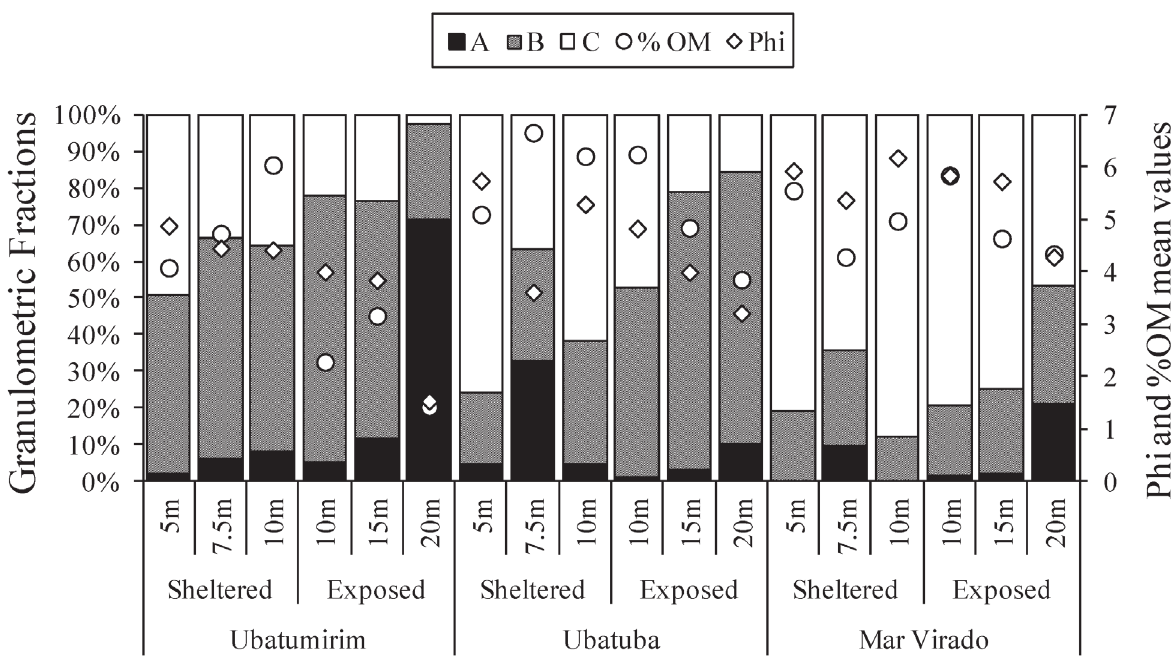
Figure 4. Sedimentological analysis showing grain size fractions (columns) and mean values of phi and %OM (percentage of organic matter) obtained from January 1998 to December 1999. A = median sand + coarse sand + gravel, B = fine sand + very fine sand and C = silt +